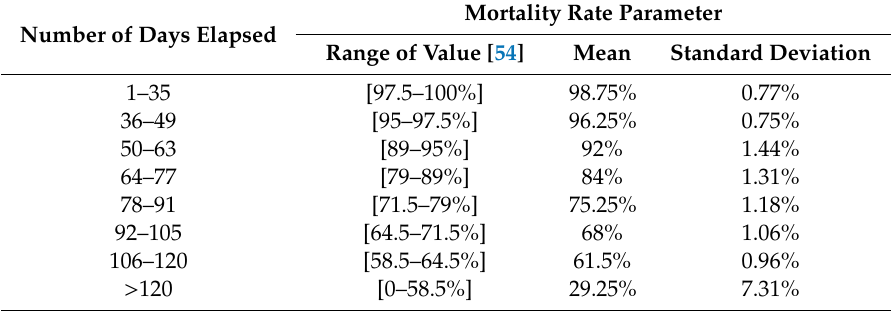
Table 3. Allocated ranges of values to mortality rate parameter regarding the number of days elapsed since application.